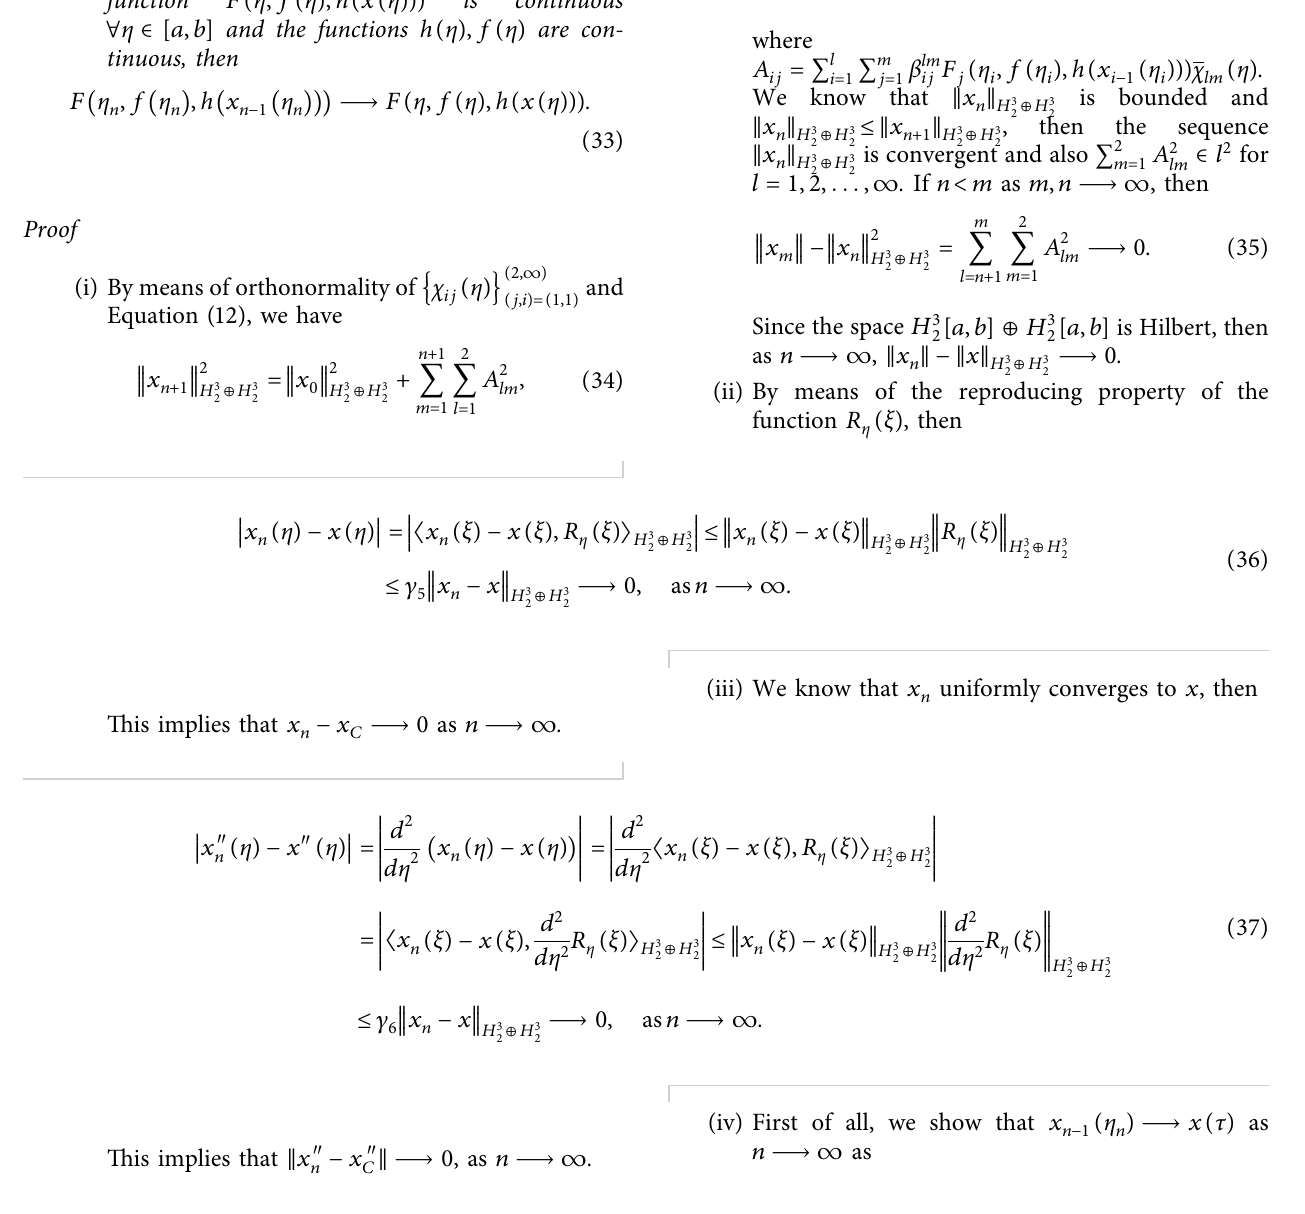
Table 1: Comparison of exact x solutions of problem (13) when η � 0 . 5 for different values of α